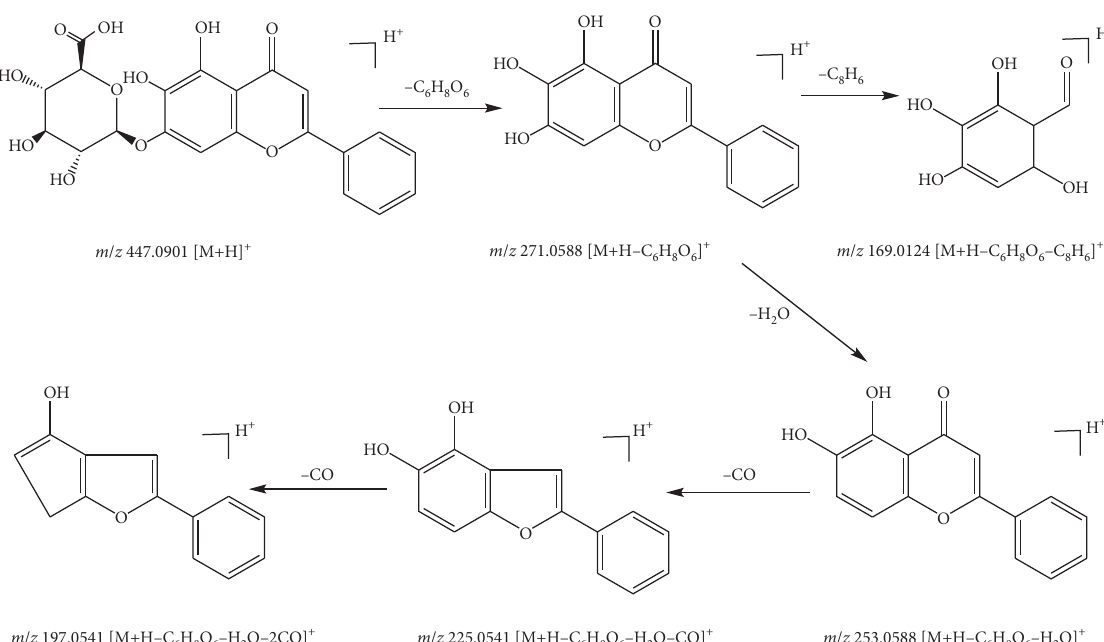
Figure 5: Possible fragmentation pathway of compound